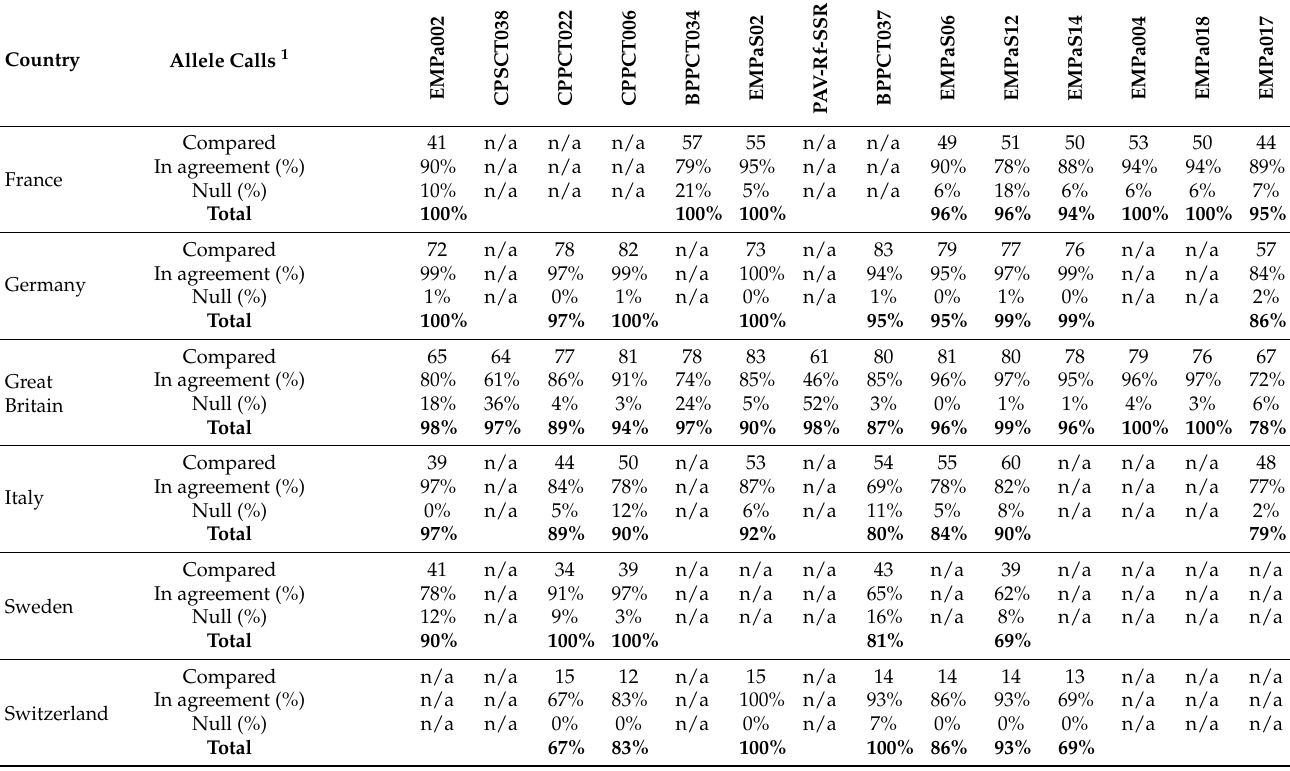
Table 2. Summary of allelic comparisons from alignment of national and central